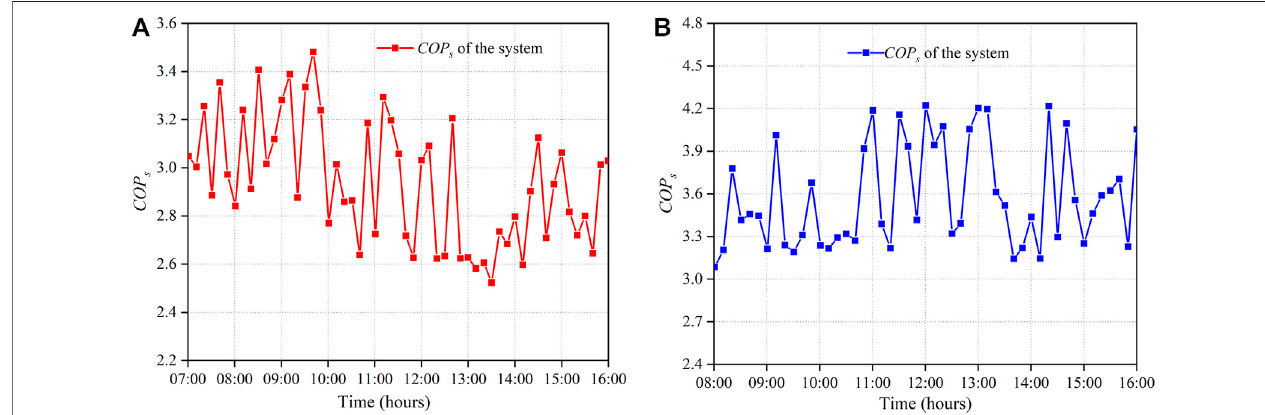
FIGURE 12 | COP s of the SWC system as a function of time for a typical day during (A) heating period (January 26, 2018) and (B) cooling period (July 4, 2017).